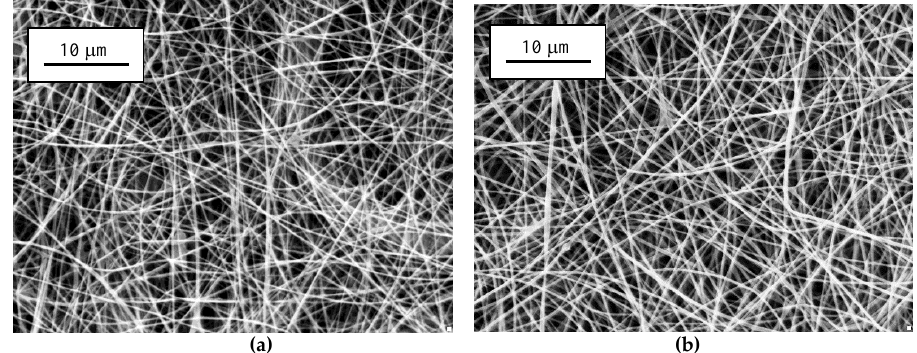
Figure 7. SEM images of SPC/PEO nanofibers collected on the V-shaped cardboard substrate with a different distance between the needle and collector: ( a ) 20 cm and ( b ) 15 cm.